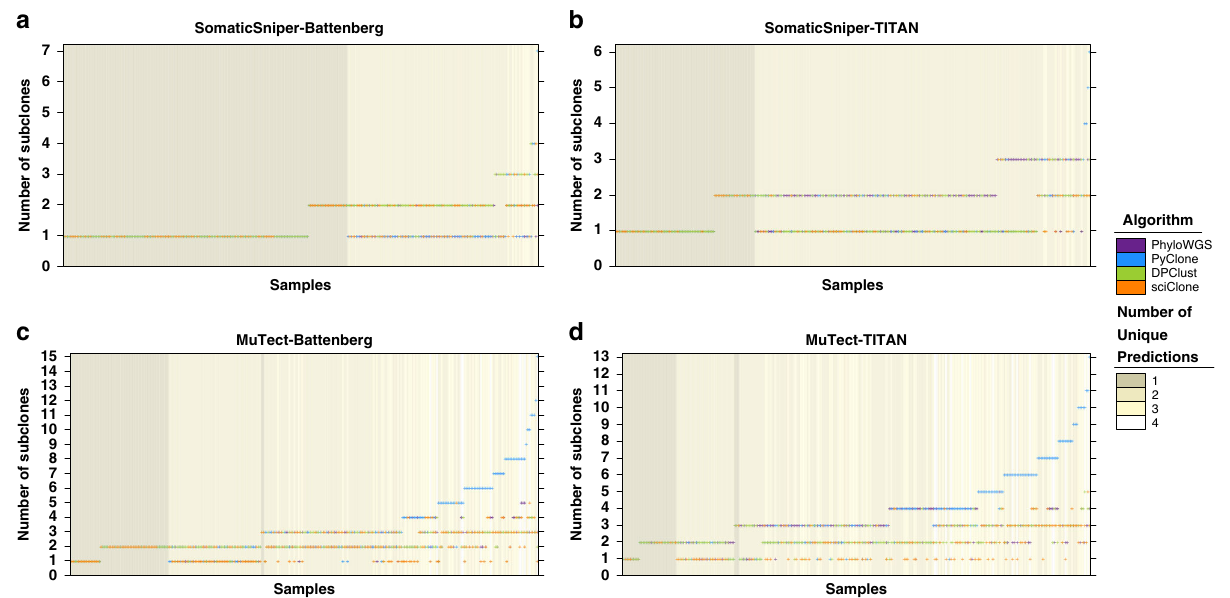
Fig. 3 SNV detection tools bias pipeline concordance in number of subclones detected. Each panel compares the number of subclones predicted for each sample by subclonal reconstruction pipelines using the same mutation detection tool combinations a SomaticSniper-Battenberg, b SomaticSniper-TITAN, c MuTect-Battenberg and d MuTect-TITAN. Each marker represents the prediction for a sample by a successful pipeline execution, and the color of the marker represents the subclonal reconstruction algorithm used in the pipeline. In cases where algorithms predicted the same number of subclones, the markers were randomly overlaid. Background color indicates the number of unique subclone number predictions across algorithms that successfully executed for that sample. SNV, single nucleotide variant. SomaticSniper-Battenberg: n = 291 biologically independent samples; SomaticSniper-TITAN: n = 293; MuTect-Battenberg: n = 288; MuTect-TITAN: n =